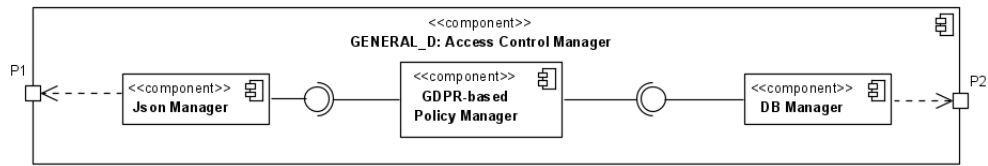
Figure 7. Overview of GENERAL_D Access Control